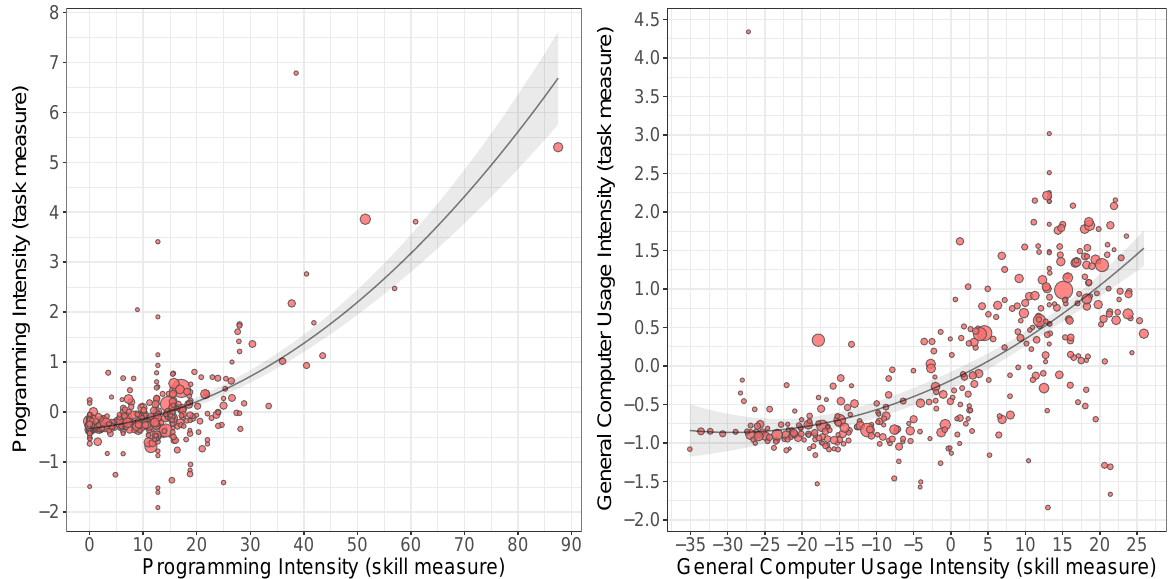
Figure 1: Occupation-level task- and skill-intensity measures of programming and general computer usage. Occupation-level task-intensity measures are based on data from the 1997, 2001, and 2003 waves of the Computer and Internet Use supplement of the CPS; occupation-level skill-intensity measures are based on data from the Occupational Information Network. Dot sizes indicate employment sizes of the corresponding occupation. The solid line and shaded area represent the quadratic fit and 95 percent confidence interval,